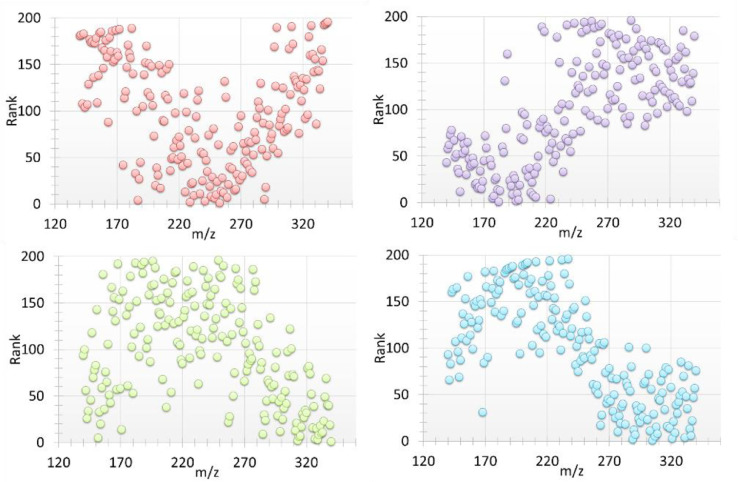
Example rank maps.